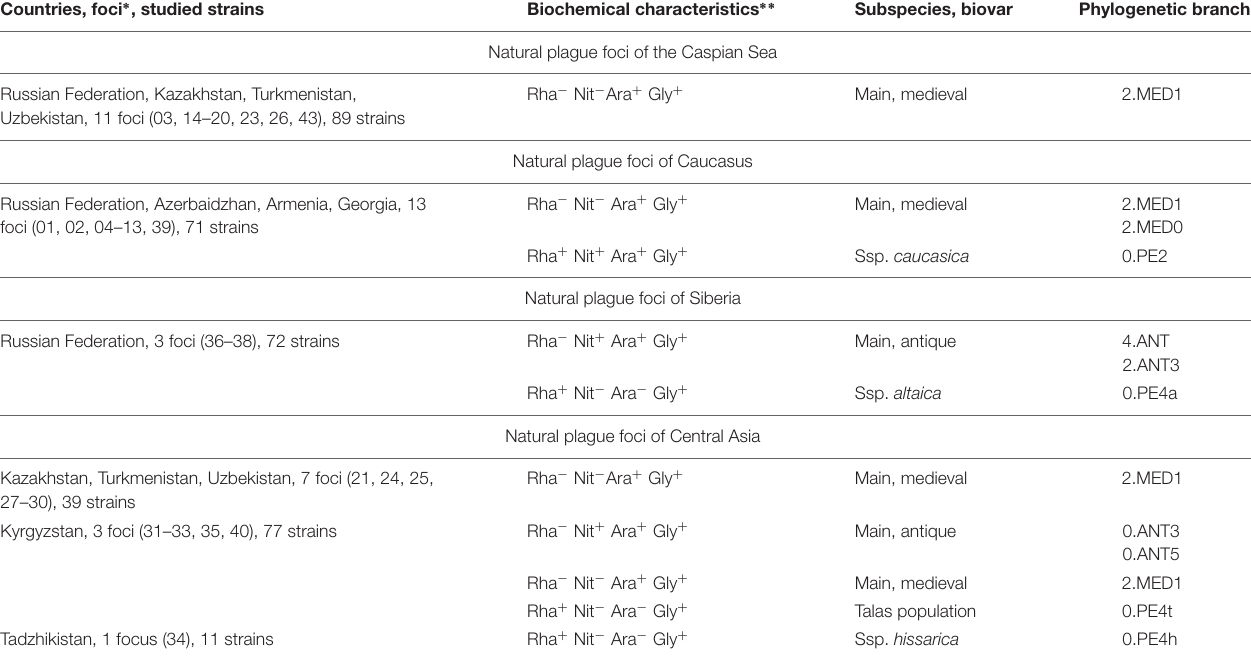
TABLE 1 | Characterization of Y. pestis strains from natural foci of plague of CIS